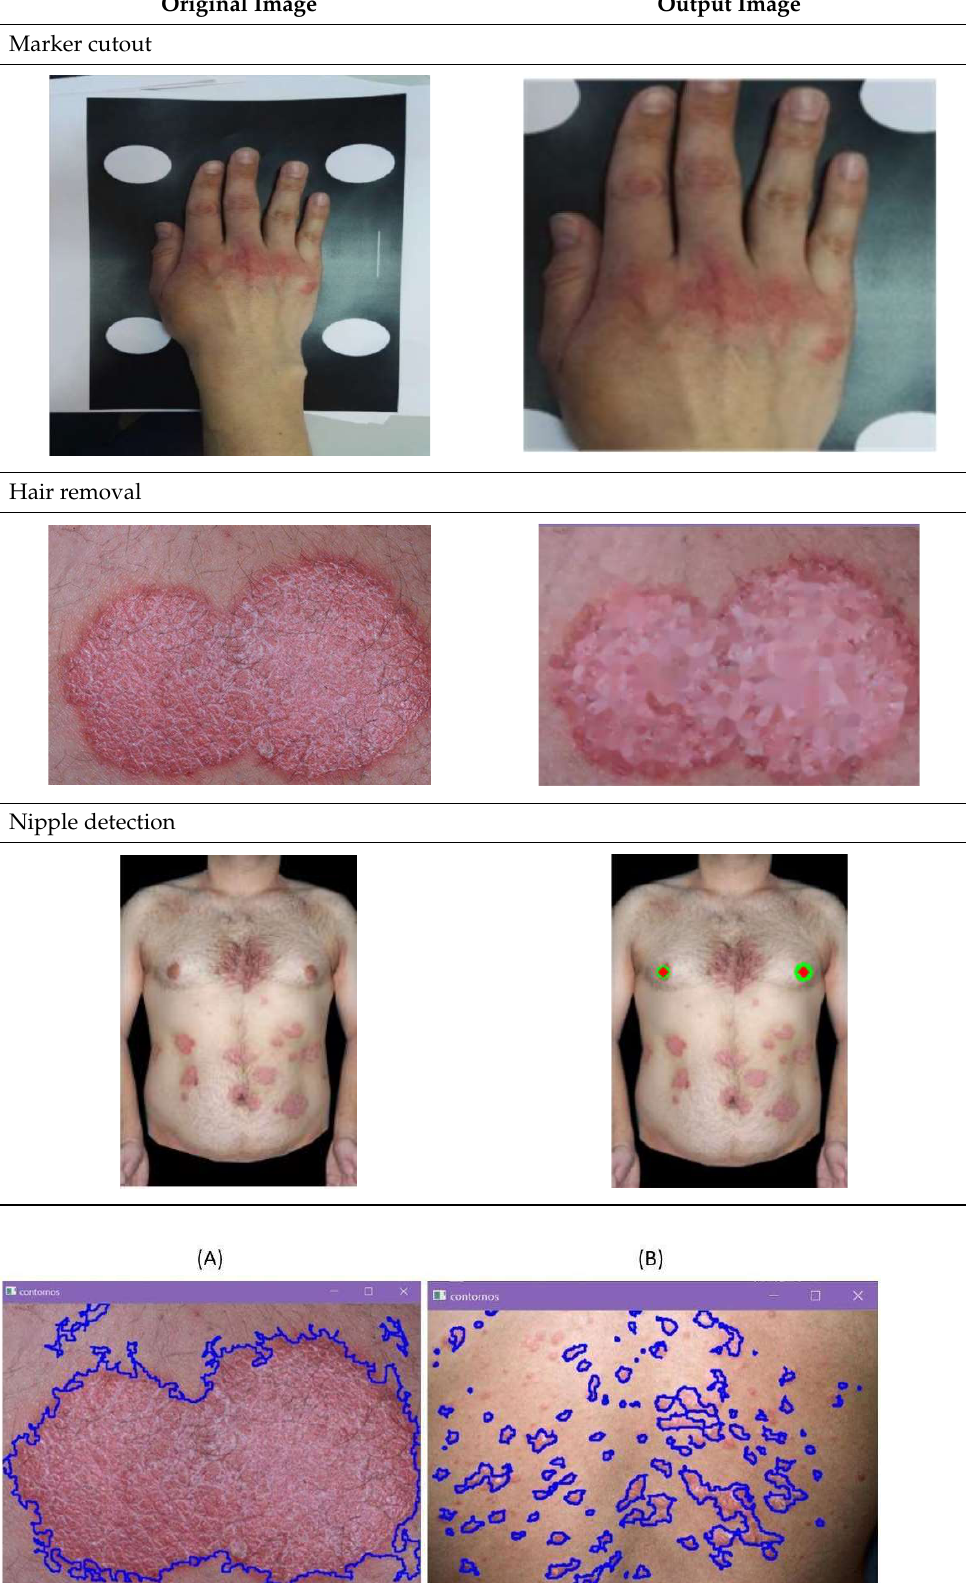
Table 1. Output images for previous preparation subroutines (after [27] and [36]).